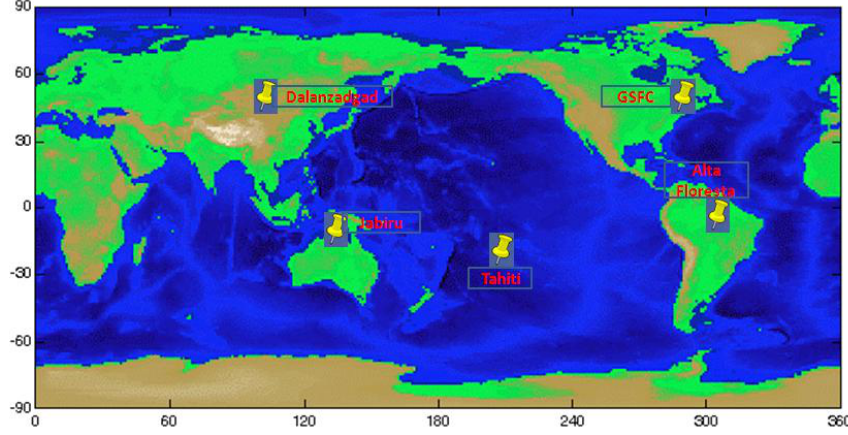
Figure 5. World map with the five selected representative sites for which the spectral evaluation of HAC AOD is attempted: GSFC (1998–2007; 38.99 ◦ N, 76.83 ◦ W), Alta Floresta (1999–2007; 9.87 ◦ S, 56.10 ◦ W), Dalanzadgad (1998–2007; 43.57 ◦ N, 104.41 ◦ E), Jabiru (2000–2007; 12.66 ◦ S, 132.89 ◦ E) and Tahiti (1999–2007; 17.57 ◦ S, 149.60 ◦ W).